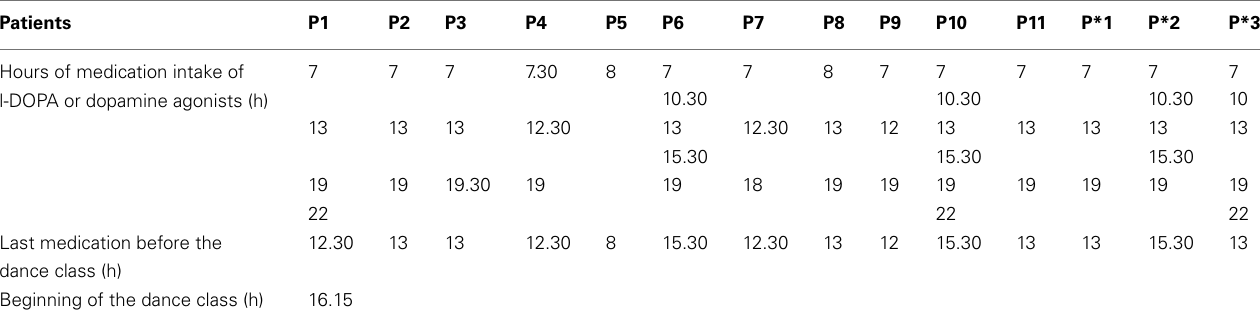
Table 5 | Hours of medication intake of l-DOPA or dopamine agonists.